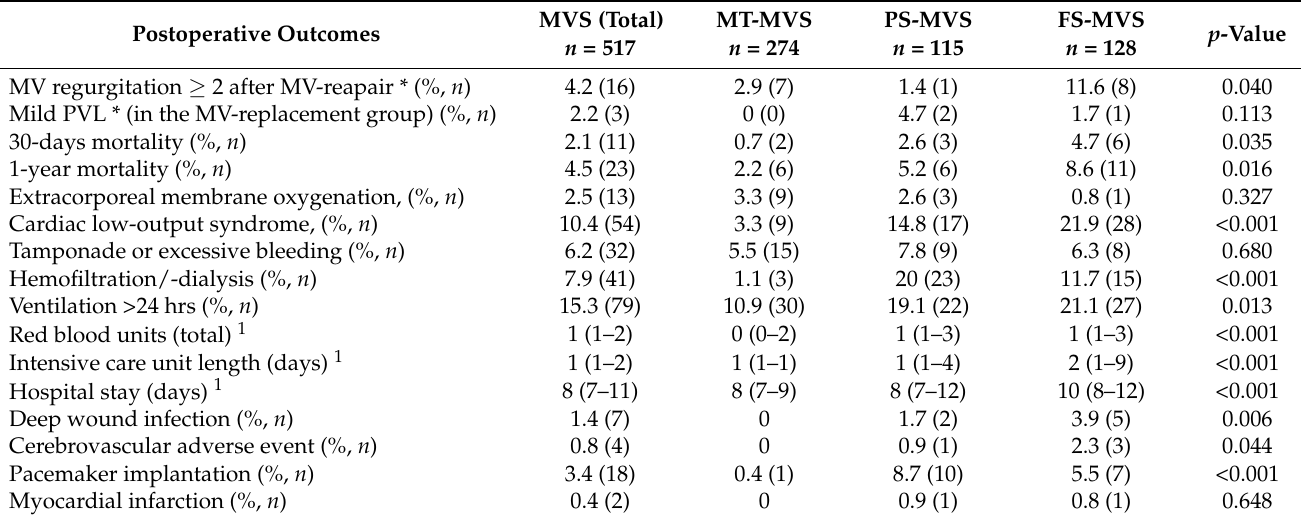
Table 4. Secondary postoperative